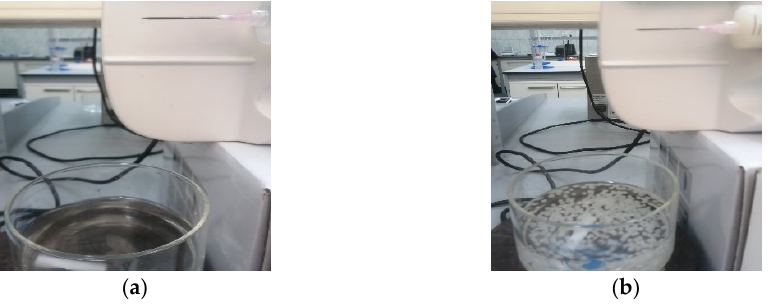
Figure 1. Dripping of 1% ALG solution ( a ) and ALG–BPA (1:1) ( b ) in a CaCl 2 bath. The beads were left overnight for reticulation in the CaCl 2 solution and then washed with distilled water until the total removal of Cl − ions (testing with AgNO 3 ). After washing, the beads were left to dry overnight, and they are presented in Figure 2.